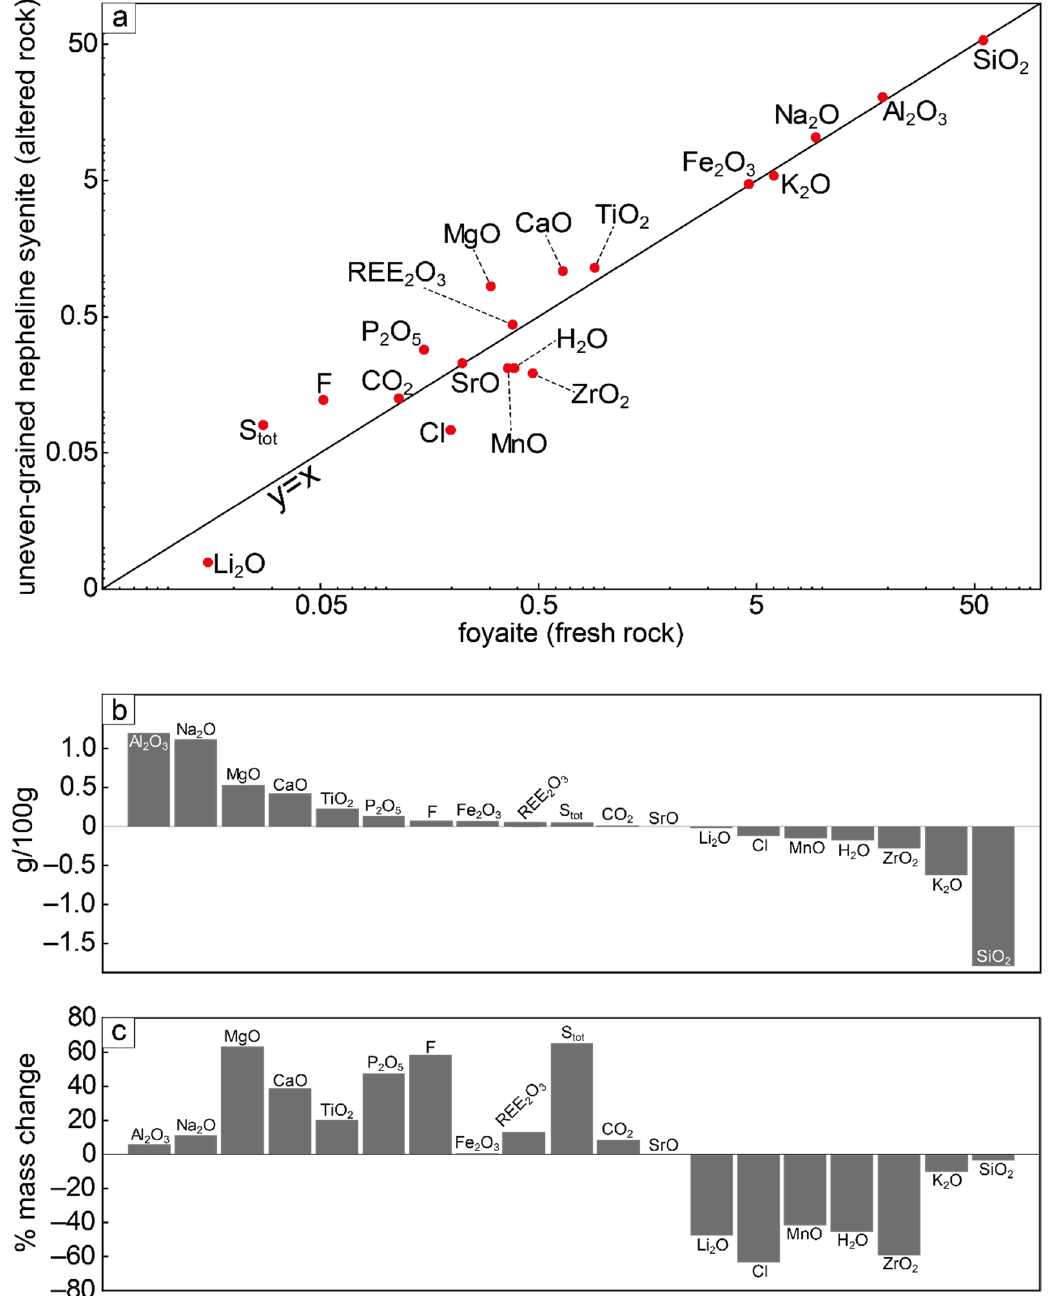
Figure 15. ( a ) Isocon diagram comparing the chemistry of uneven-grained nepheline syenite (altered rock) and foyaite (fresh rock); ( b , c ) bar diagrams showing the gains and losses of major oxides and elements.